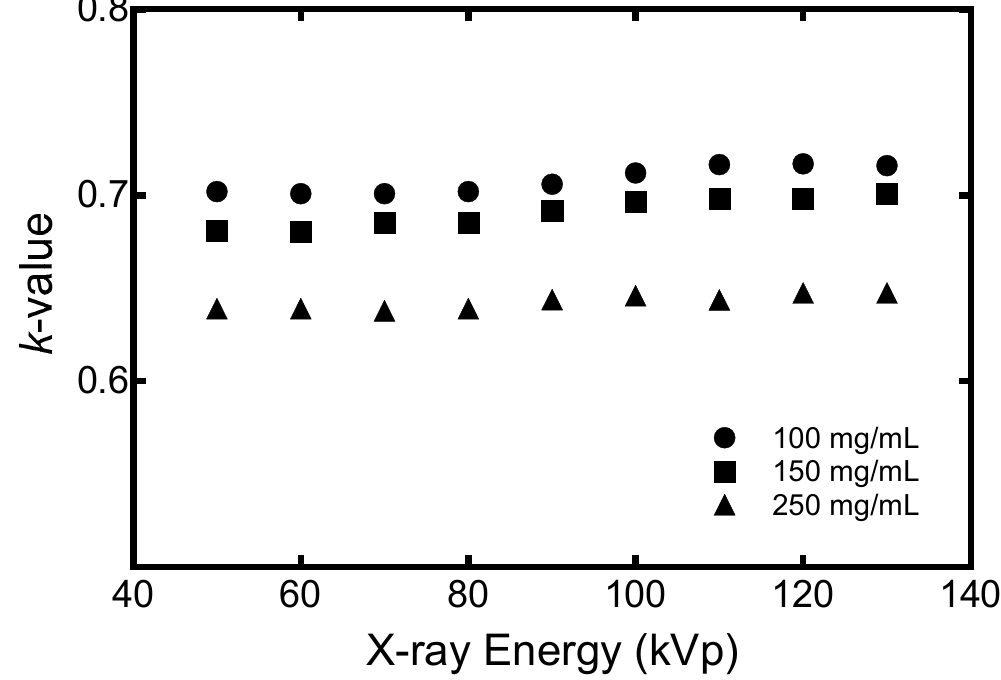
Figure 3. The optical photon transmission per 5 µ m ( k value) for the 100 mg / mL, 150 mg / mL, and 250 mg / mL ZnCuInS / ZnS concentrations.